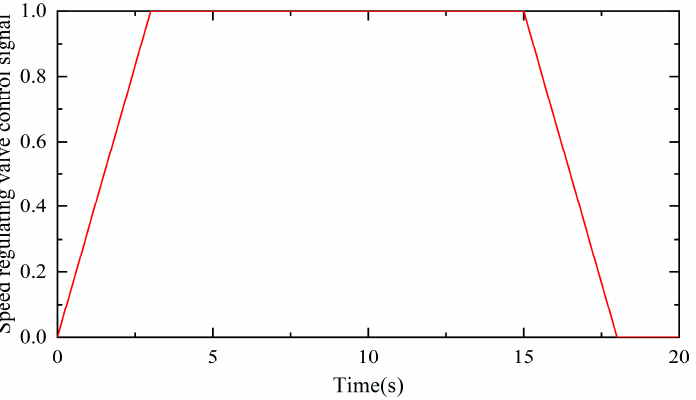
Figure 7. The control signal of the speed regulating valve. The noncoincidence of the radial force bearing point and slewing point of the sail leads to the wind resistance moment, as is shown in Figure 8.